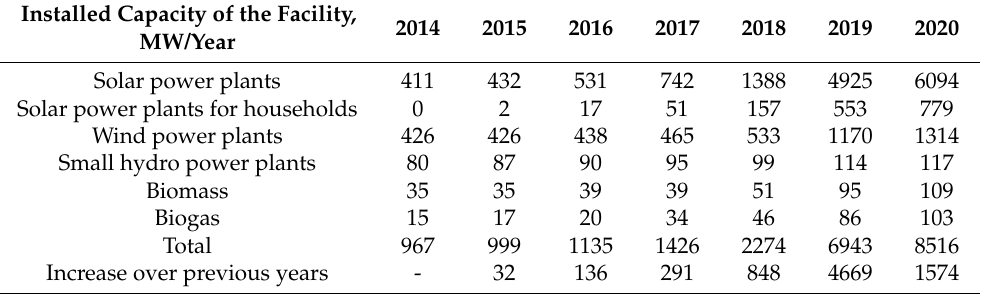
Table 3. Installed capacity of renewable energy facilities in Ukraine 2014 – 2020 [24].